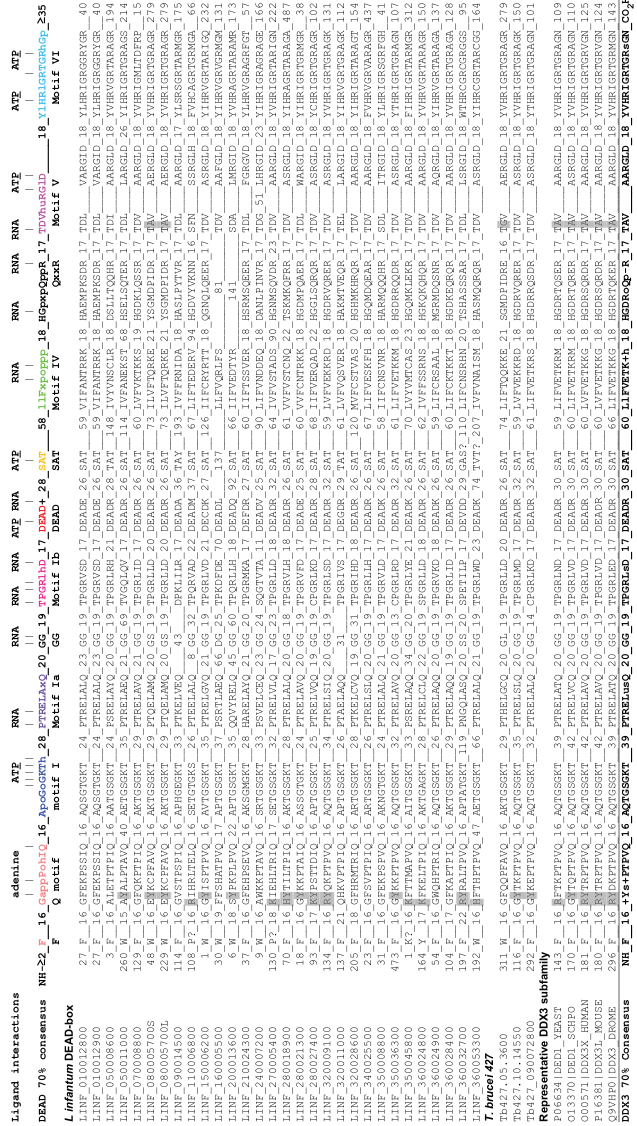
Figure 2. Alignment of the helicase cores of DEAD-box proteins of Leishmania . The protein sequence of the 28 different proteins is shown with representative members of the Ded1/DDX3 subfamily of proteins. Note that LINF_010012800 and LINF_010012900 encode the same protein, and both the long and short forms of LINF_080005700 are shown. LINF_050006300 was found after this work was completed. The DEAD-box consensus was derived from 700 sequences from different organisms as previously described [56]. The capital case letters are conserved amino acids and the lowercase letters indicate functional conservation, where a is an aromatic group, l is an aliphatic residue, h is hydrophobic, o is an alcohol, + is positively charged, p is polar, u is tiny, and x is any residue. The numbers signify the typical distances between motifs. The interactions with the RNA and ATP are as shown, based on the solved crystal structures of the ligand-bound DEAD-box protein Vasa (PDB# 2DB3; [80]). However, these interactions are largely conserved in all the solved crystal structures of DEAD-box proteins. The underlined P shows interactions with the phosphates of ATP, while the adenine is from ATP. The helicase core is defined by 2–3 residues that extend from the amino terminus of the conserved phenylalanine of the Q motif and about 33–35 residues that extend from the carboxyl terminus of motif VI. Similarly, the Ded1/DDX3 subfamily consensus was derived from 96 of the original 229 unique sequences with the closest homology to yeast Ded1. Residues distinctive for this subfamily are shown in